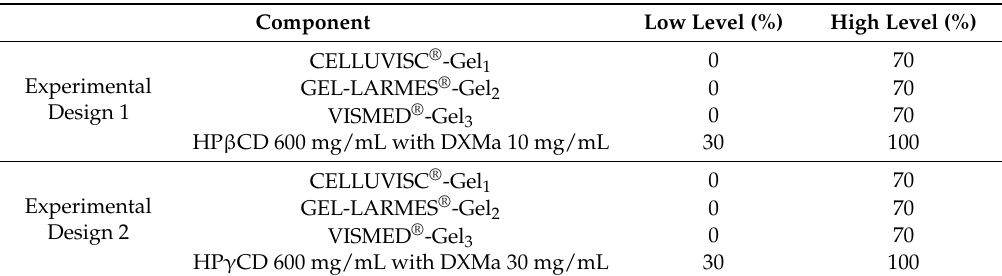
Table 2. Low and high levels of formulation components for special cubic mixture designs.